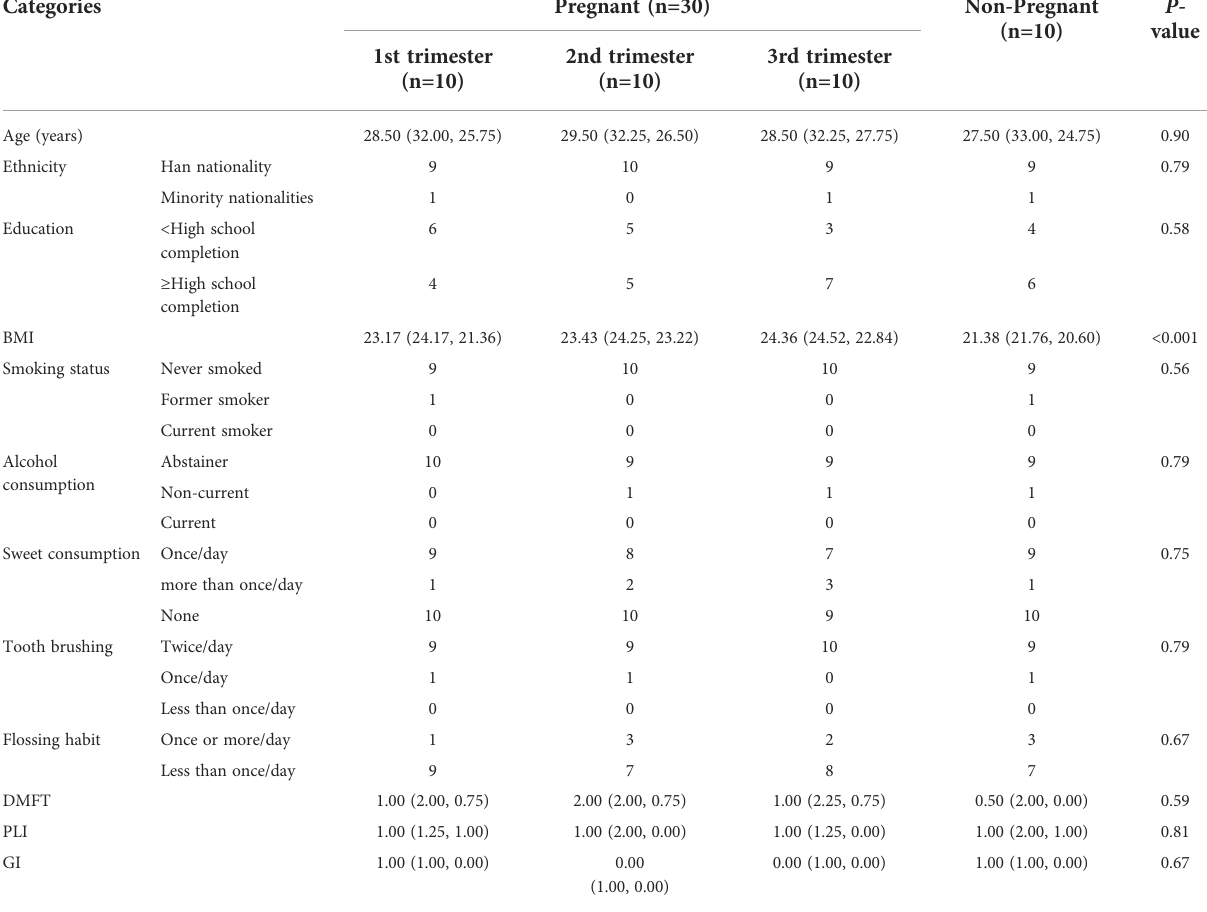
TABLE 1 Demographic, medical, and oral status characteristics of study